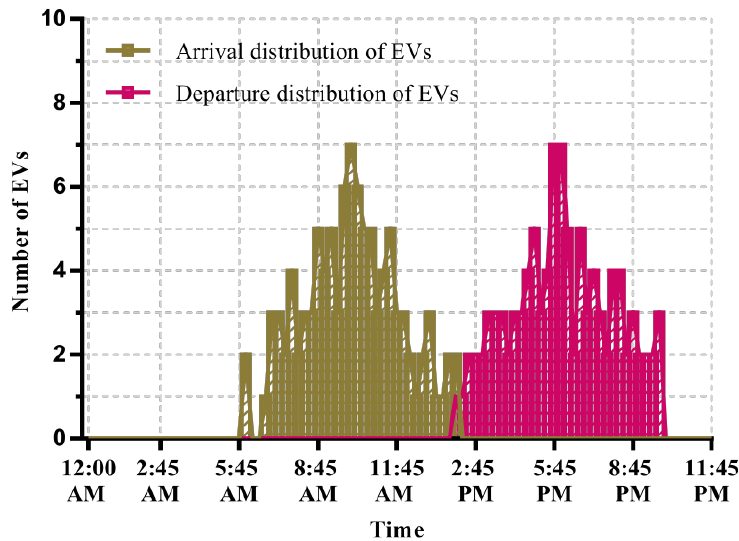
Figure 10. Arrival and departure distribution of electric vehicles (EVs).